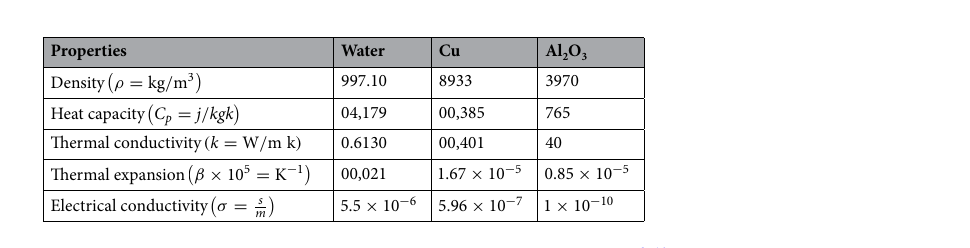
Table 1. The numerical properties of Cu & Al 2 O 3 nanoparticles as 8–10